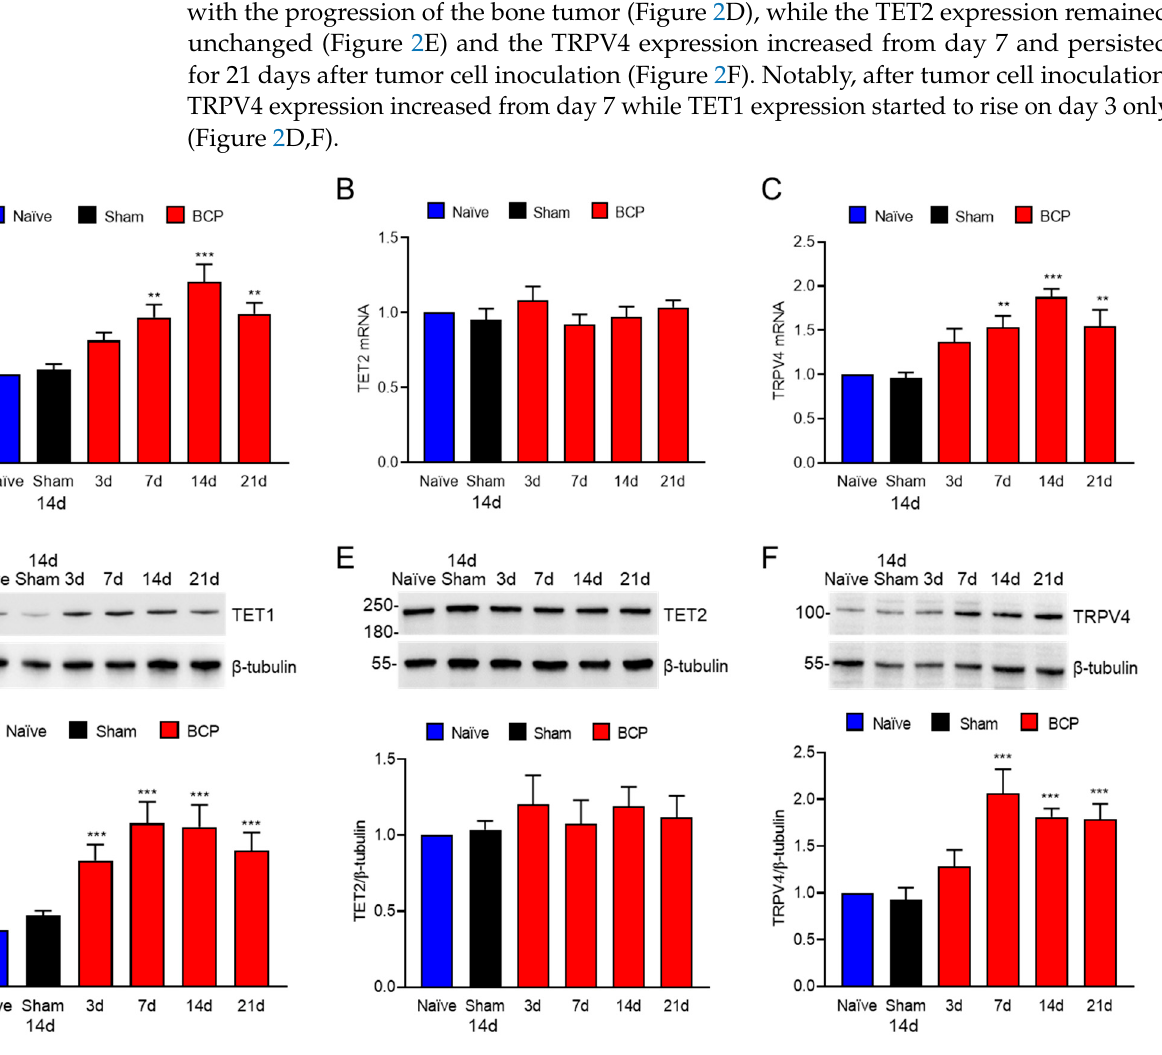
Figure 2. TET1 and TRPV4 were increased by qPCR and Western blotting at day 0, 3, 7, 14, and 21 in L4–6 DRG of BCP rats after tumor cell inoculation. ( A ) qPCR assay showed that TET1 mRNA increased with tumor progression (** p < 0.01, *** p < 0.001 vs. sham, n = 4, one-way ANOVA). ( B ) Compared with the sham group, TET2 mRNA has no significant difference at each time point. ( C ) qPCR assay showed that TRPV4 mRNA increased with tumor progression (** p < 0.01, *** p < 0.001 vs. sham, n = 4, one-way ANOVA). ( D ) Compared with the sham group, TET1 expression began to increase on the 3rd day after tumor cell inoculation and reached the highest level on the 7th day, and remained until the 21st day (*** p < 0.001 vs. sham, n = 4, one-way ANOVA). ( E ) TET2 expression was not significantly different from the sham group after tumor cell inoculation. ( F ) Compared with the sham group, TRPV4 expression began to increase on the 7th day after tumor cell inoculation (*** p < 0.001 vs. sham, n = 4, one-way ANOVA). 3.3. TET1 and TRPV4 Were Mainly Expressed in the L4–6 DRG CGRP and IB4 Neurons of BCP Rats Using an immunofluorescence assay, we looked into the distribution of TET1 and TRPV4 in L4–6 DRG further. As shown in Figure 3, TET1 was mainly expressed in neurons (labeled by NeuN) but not satellite glial cells (labeled by GS, glutamine synthetase, a marker of satellite glial cells in DRG). TET1 was also co-stained with CGRP (calcitonin gene-related peptide, a marker of small and medium peptidergic neurons) and IB4 (iso- lectin B4, a marker of small and medium non-peptidergic neurons), and the results re-